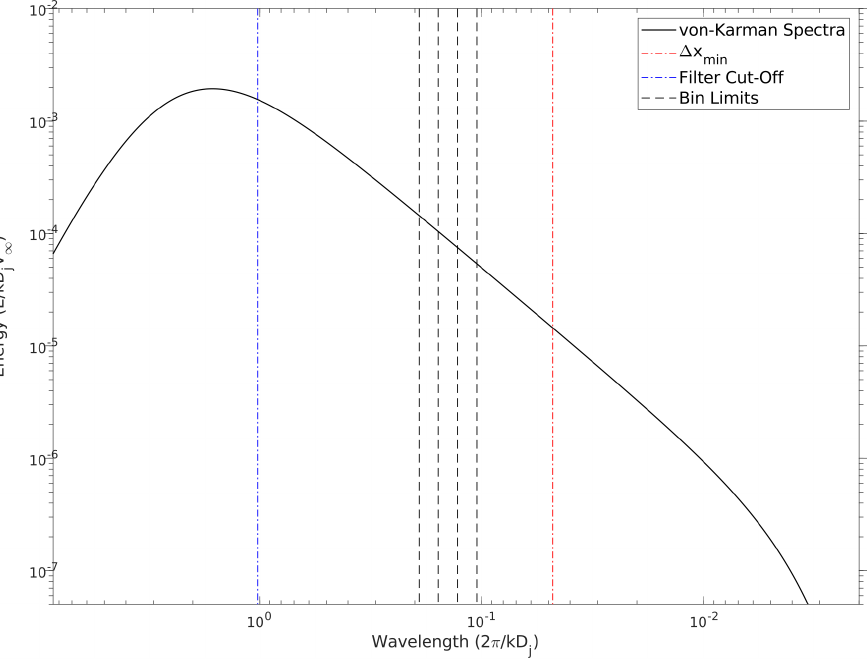
Figure 4. Eddy Size Distribution Shown for a Representative Turbulent Spectrum. The eddy size is randomly chosen uniformly over the limits of the bin. Upon re- initialization, the eddies stay in their assigned bin, but the size can change within the limits of the bin. This ensures that the desired size distribution is maintained but allows for randomness in eddy